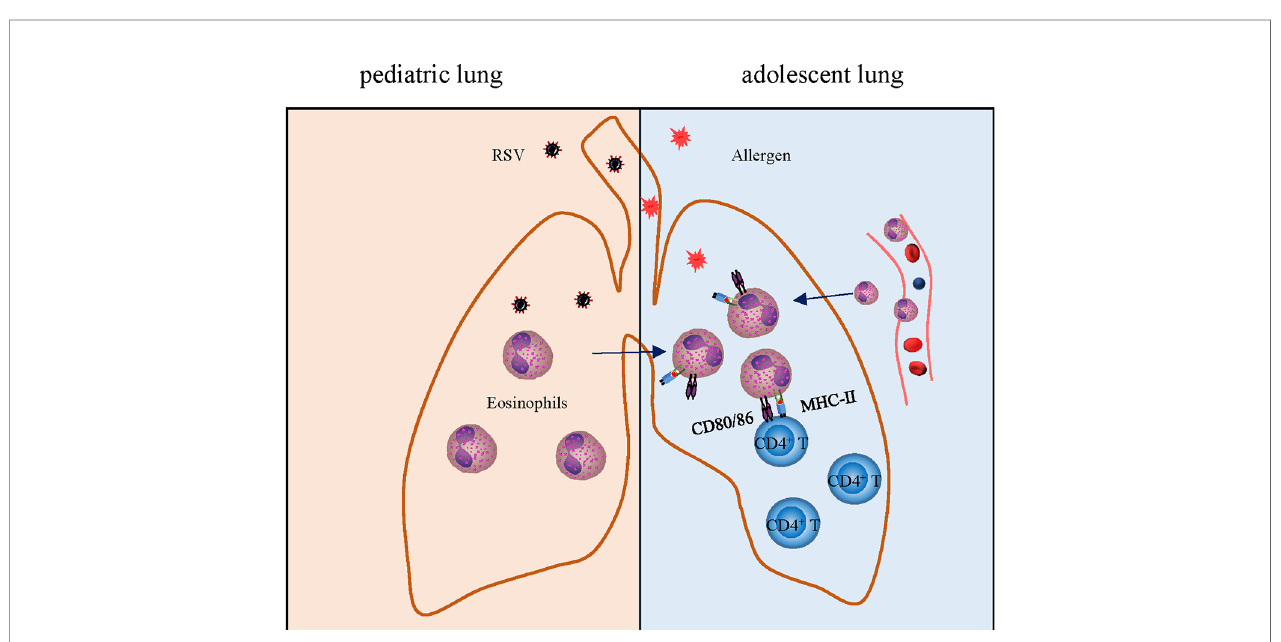
FIGURE 7 | Schematic drawing showing the role of eosinophils in enhanced allergic asthma after early-life infection with RSV. Early-life infection with RSV leads to an increase of eosinophils leading to asthma pathology aggravation later in life, which links to airway remodeling, enhanced antigen presentation, and in fl